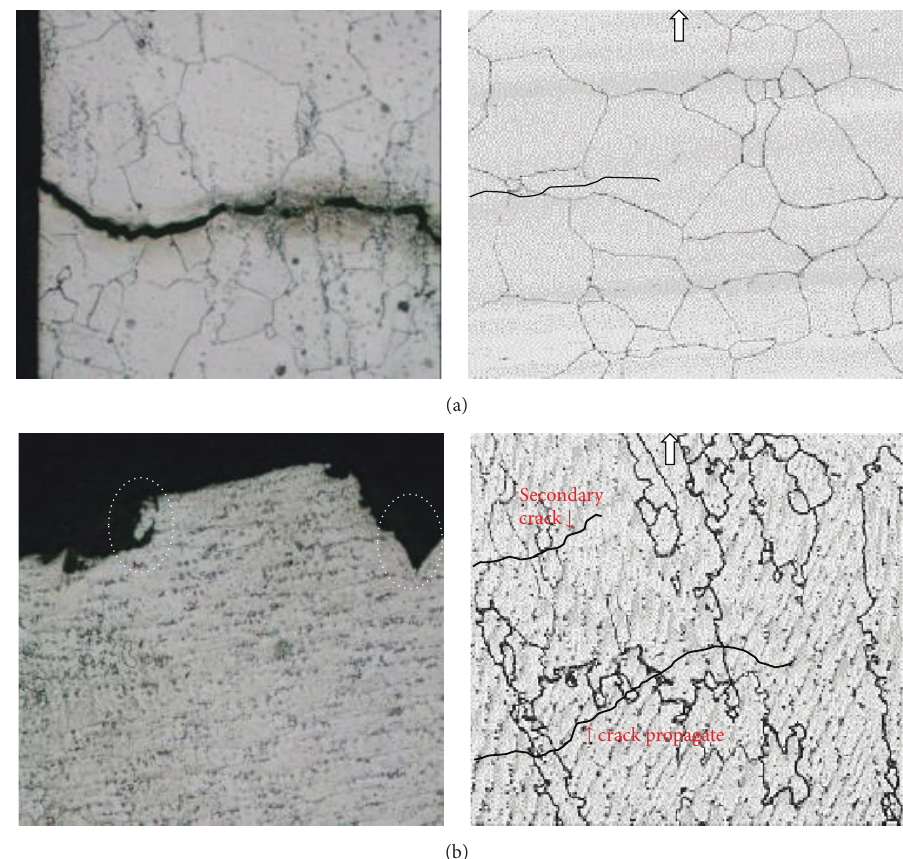
Figure 13: Schematic illustrations of the failure mechanism in pure fatigue representing a transgranular crack initiation and propagation along the fracture surfaces for (a) Alloy 617 BM and (b) Alloy 617 WJ, tested at 1.5% total strain range, RT.